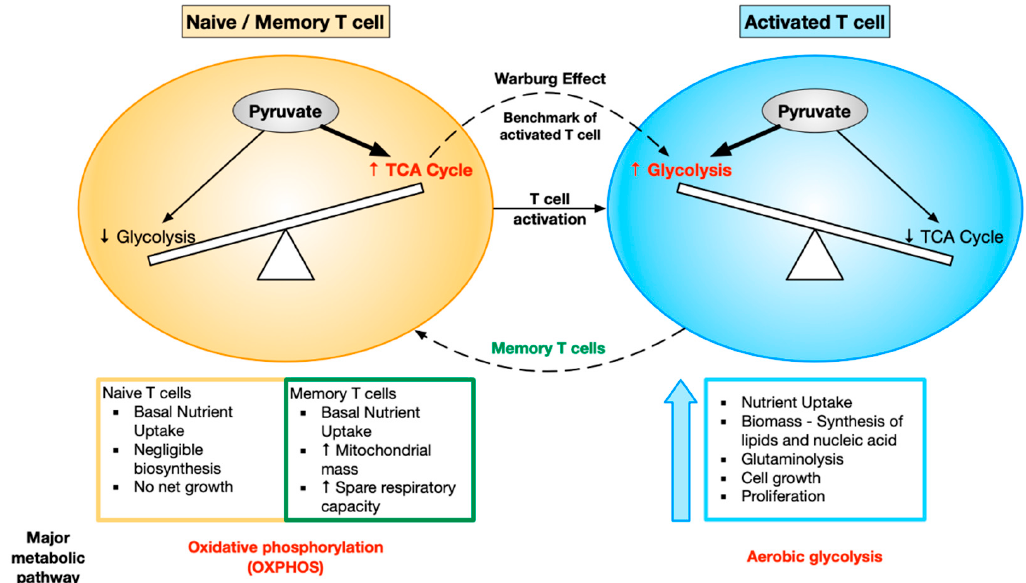
Figure 2. Different metabolic demands of naive, activated, and memory T cells. Naive and memory T cells skew towards oxidative phosphorylation (OXPHOS), whereas activated T cells skew towards aerobic glycolysis. This metabolic shift in the T cells (OXPHOS → aerobic glycolysis) is the activation benchmark known as the Warburg effect. The naive T cells are quiescent in nature, with no net growth, whereas activated T cells show boosted nutrient uptake and growth in biomass, ultimately leading to cell growth and proliferation. Memory T cells have basal nutrient uptake, but they show increased mitochondrial mass and spare respiratory capacity, helping them increase their longevity.